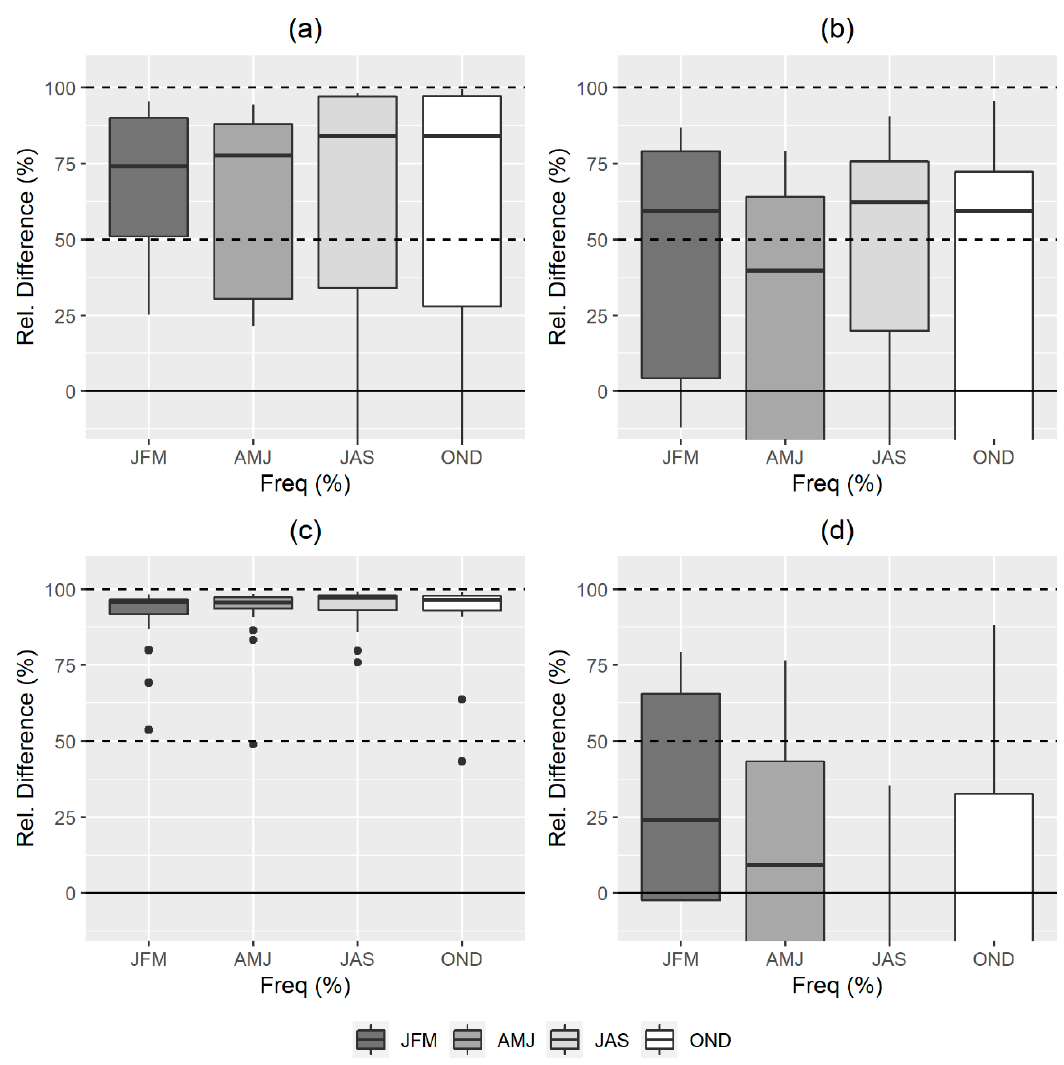
Figure 10. Percentage of reduction per season for gauge ( a ) 56028000 / RD001, ( b ) 56075000 / RD007, ( c ) 56110005 / RD013 and, ( d ) 56539000 / RD023. JFM, January to March; AMJ, April to June; JAS, July to September; OND, October to December. Table 3. Needed E. coli reduction (RD) per regime of flow and per season in the Piranga basin. Gauge